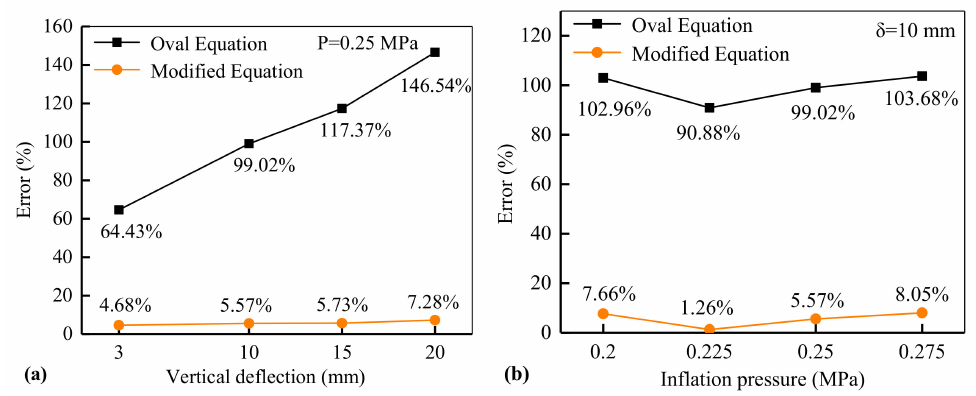
Figure 12. Estimation error of passenger car tire contact force: ( a ) different vertical deflection; ( b ) different inflation